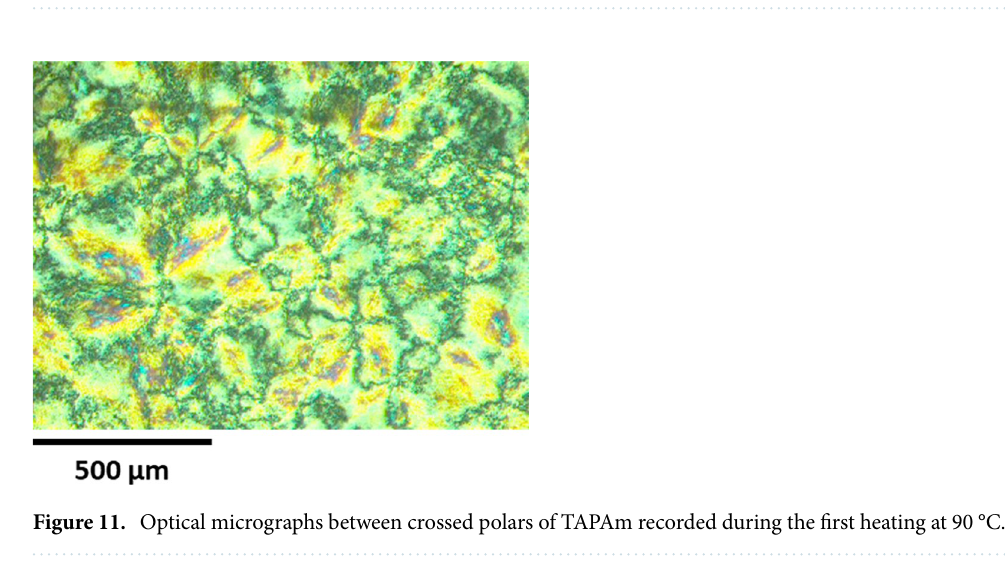
Figure 10. XRD patterns of TAPAm recorded on heating at: ( a ) 70 °C, ( b ) 90 °C and ( c ) 110 °C on first heating; and ( d ) 80 °C and ( e ) 110 °C on second heating.